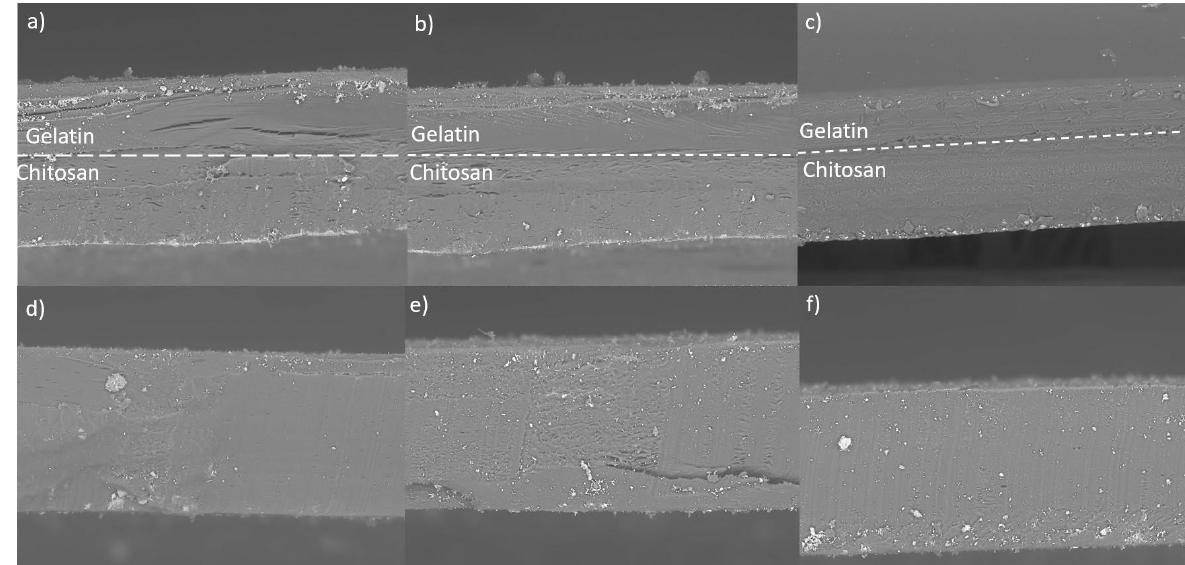
Figure 3. Observation of the thickness of the films in SEM: ( a ) 3% gelatin composite, ( b ) 2.5% gelatin composite, ( c ) 2% gelatin composite, ( d ) 3% gelatin bi-layer, ( e ) 2.5% gelatin bi-layer, ( f ) 2% gelatin bi-layer.